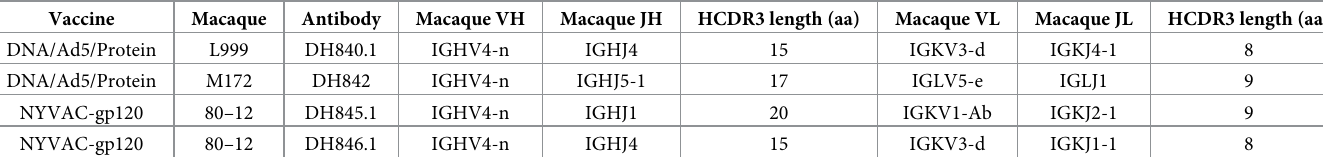
Table 1. Immunogenetics determined by Cloanalyst rhesus macaque